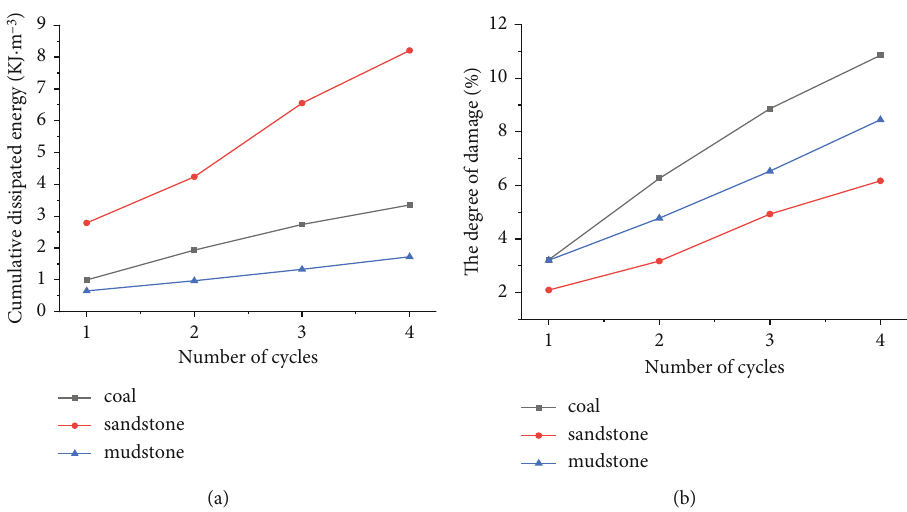
Figure 12: (a) Average cumulative dissipated energy. (b) Average degree of rock damage.